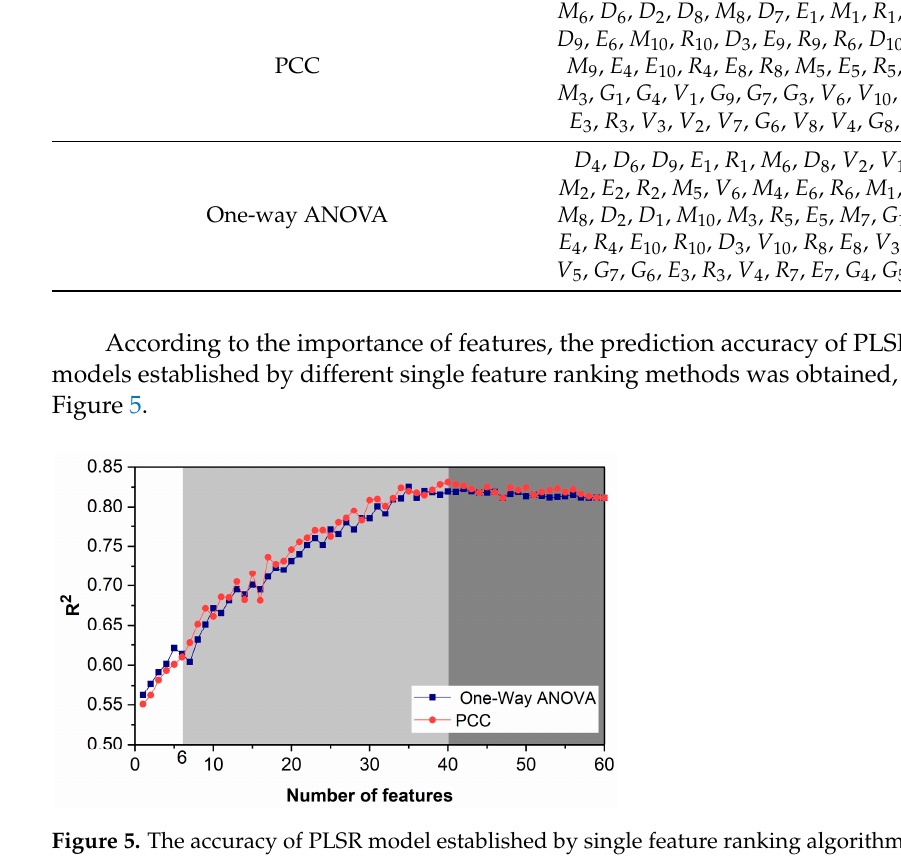
Table 3. Feature importance ranking in single feature ranking methods.